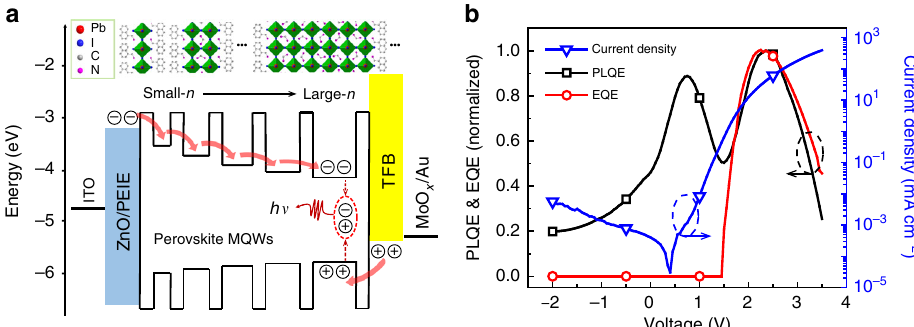
Fig. 1 Device structure and ef fi ciency roll-off of perovskite MQW LEDs. a Schematic representation of the fl at-band energy level diagram and structures of the 30-nm thick perovskite MQW fi lm which is an assembly of different layered lead halide perovskites with various n numbers. The n number determines the bandgap of each quantum well. The MQW structure enhances the probability of radiative recombination. b Dependence of current density (blue triangles), normalized PLQE (black square), and EQE (red circle) on the driving voltage. The PLQE and EQE were measured simultaneously on a working LED device. The excellent correlation between the PLQE and EQE at high current intensities indicates that luminescence quenching is responsible for